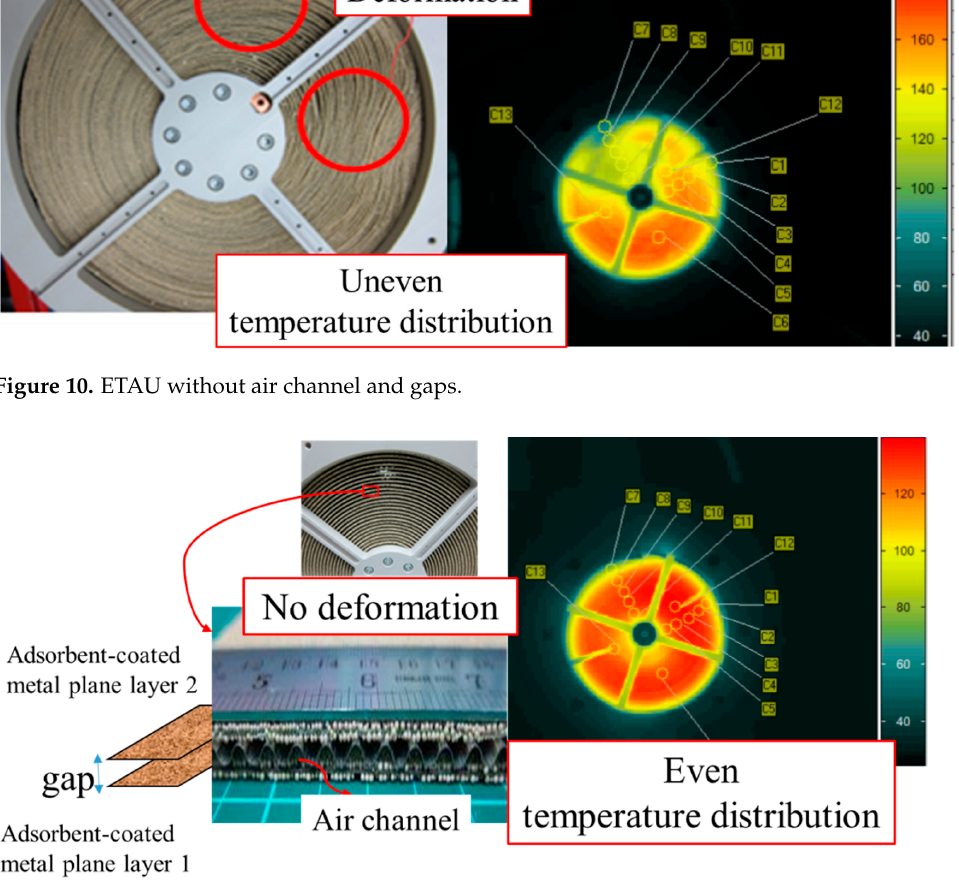
Figure 11. ETAU with parallel channel design.